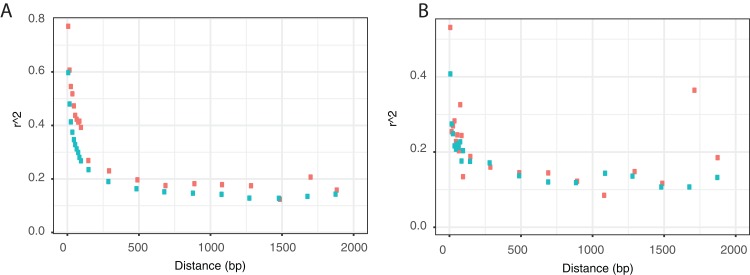
Decay in linkage disequilibrium with the distance between sites.Linkage disequilibrium, as measured by r2 (Hill & Robertson, 1968), between pairs of polymorphic sites as a function of the distance between sites for (A) all sites and (B) for those sites not inferred to have undergone hLGT. Each point represents the average r2 between all pairs of points separated by a certain distance in bins of 10 bp between 0 and 100 bp, a bin of 101–200 bp and then bins of 200 bp up to 800 bp. N. meningitidis in green, N. gonorrhoeae in red.